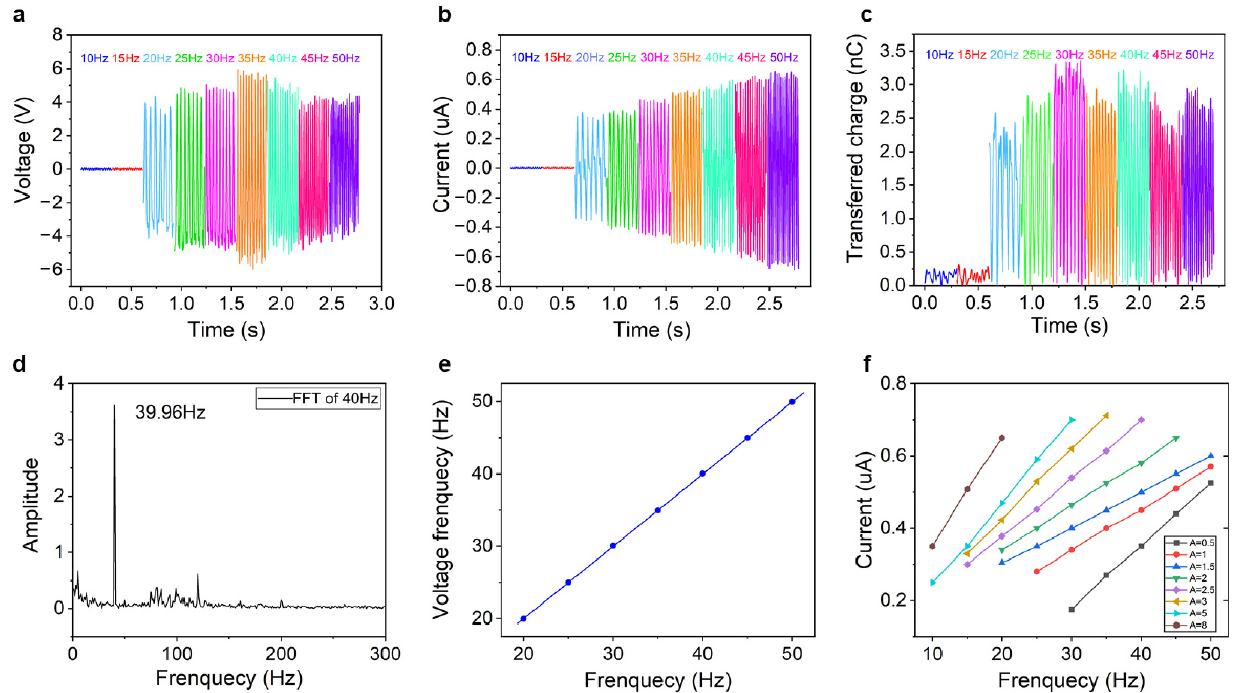
Figure 3. The vibration frequency monitoring characteristics of BB-TENG sensor with a ball diameter of 8 mm and container cylinder height of 10 mm. The ( a ) open-circuit voltage, ( b ) short-circuit current, and ( c ) transferred charge of BB-TENG sensor at different frequencies with a fixed vibration amplitude of 1.5 mm; ( d ) the FFT of the open-circuit voltage signal of the BB-TENG sensor with vibration frequency of 40 Hz; ( e ) the consistency between the vibration frequency and the FFT result of open-circuit voltage signal; and ( f ) relationships among the vibration frequency, vibration amplitude, and output short-circuit current of the BB-TENG sensor.